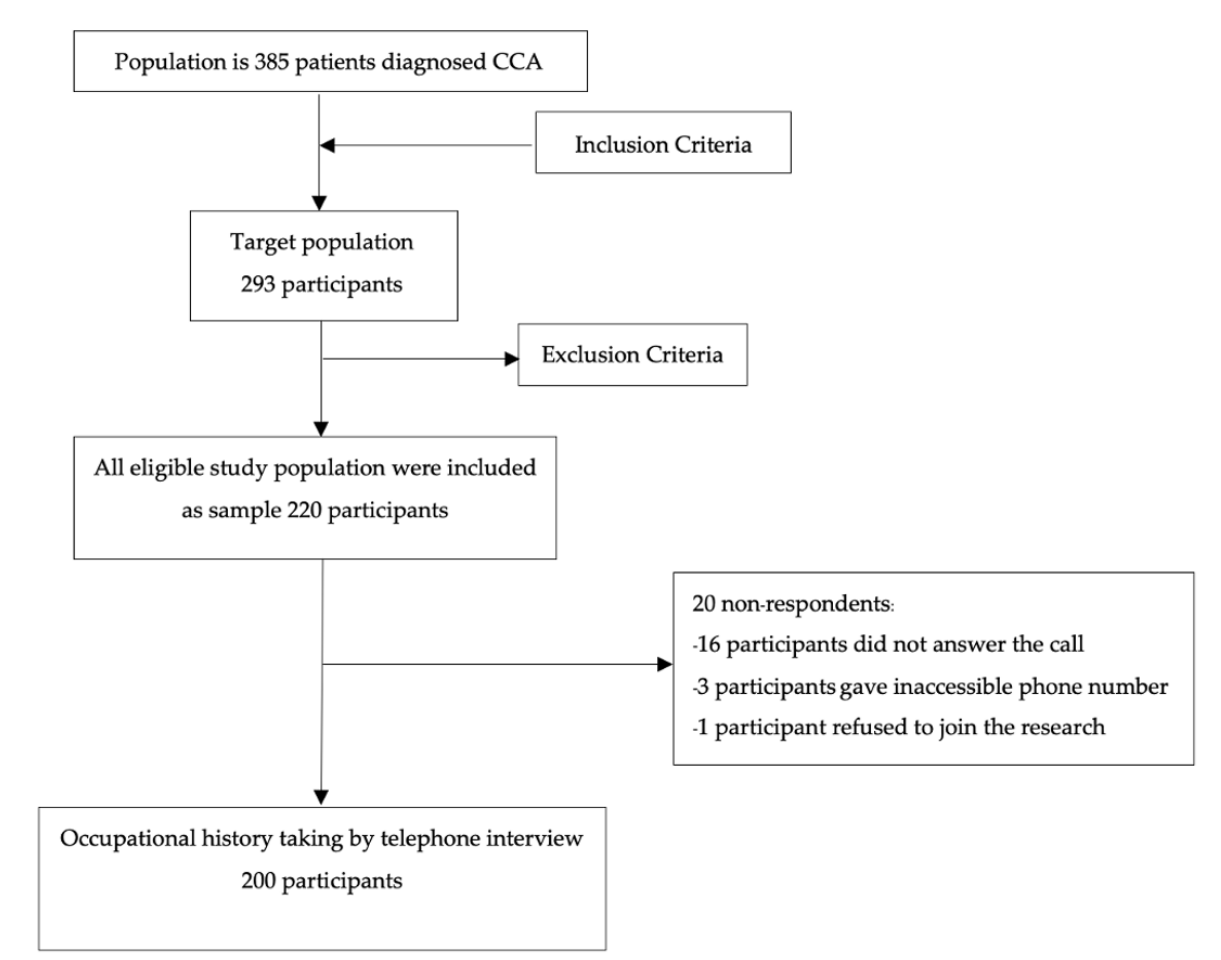
Figure 1. Flow chart of study population and sampling process.